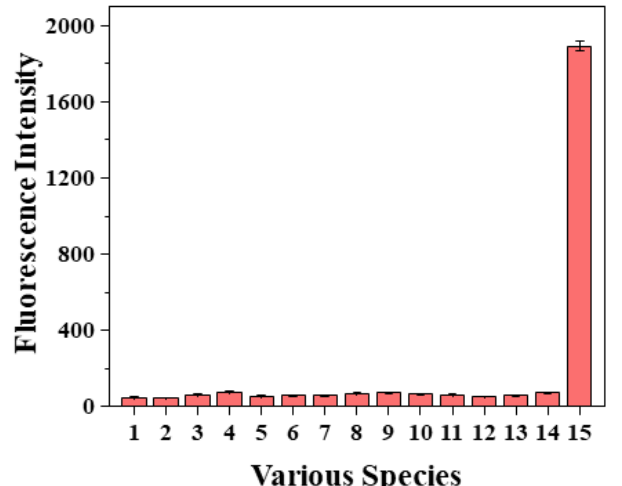
Figure 2. The response of HDBT-ONOO - (10 μM) to various species: (1) probe only; (2) ClO – ; (3) NO; (4) • OH; (5) • O 2 –; (6) 1 O 2 ; (7) H 2 O 2 ; (8) Na + ; (9) Ca 2+ ; (10) Mg 2+ ; (11) Zn 2+ ; (12) Fe 2+ ; (13) Al 3+ ; (14) Cu 2+ ; (15) ONOO – . The experiments were repeated three times, and the data are shown as the mean (± SD). All data were obtained in PBS (10 mM, pH 7.4) at room temperature. λ ex = 450 nm.